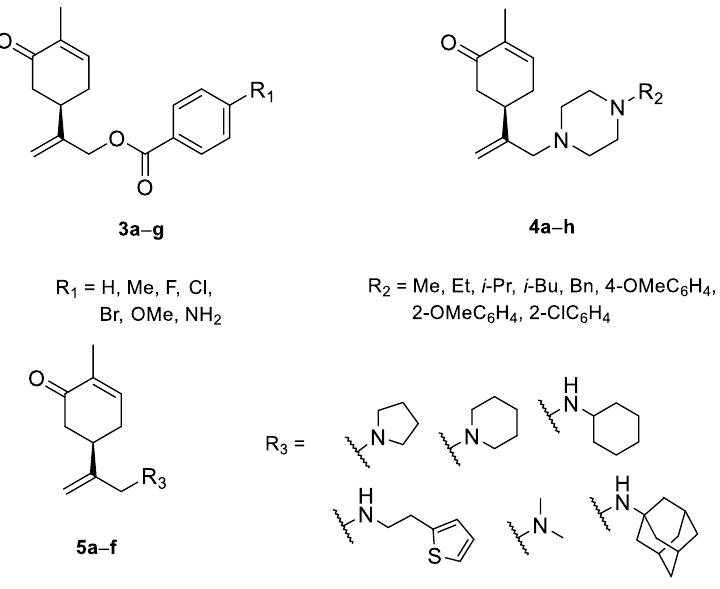
Figure 3. Carvone derivatives with anticancer activities.